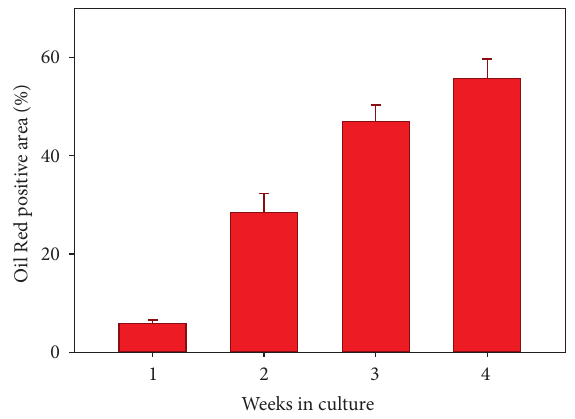
F 2: Percent of the cross-sectional area of aggregates which is stainedwithOil-Redpositive(donors 30–60 40x �elds were measured for each group). All aggregates were formed in adipogenic medium.